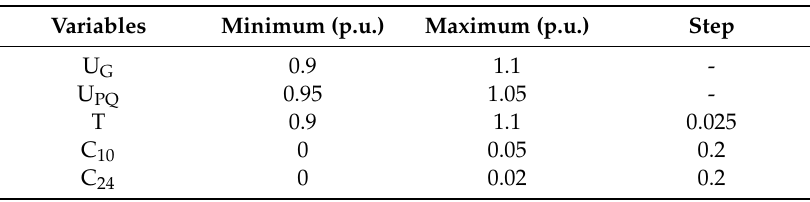
Figure 3. IEEE 30 bus power system. Table 4. Control variable setting.